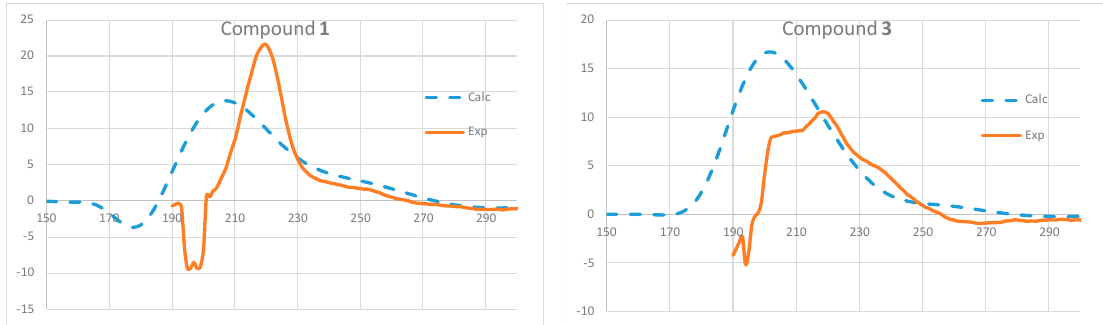
Figure 4. Experimental and calculated CD spectra of compounds 1 and 3 .